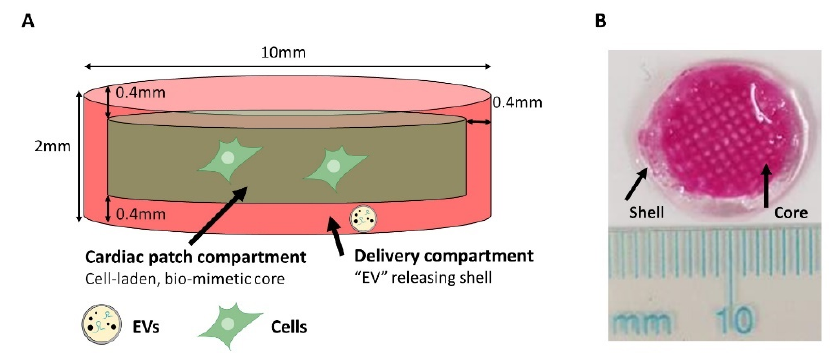
Figure 1. Cardiac patch design. ( A ) Schematic description of the designed cardiac patch. The inner core contains the cardiac cells; the outer shell contains EVs, affinity bound with AlgS, for EV delivery purposes. ( B ) Image of the EV-containing cardiac patches, fabricated by 3D printing. Polystyrene beads were used instead of cells for visualization purposes of the inner core.